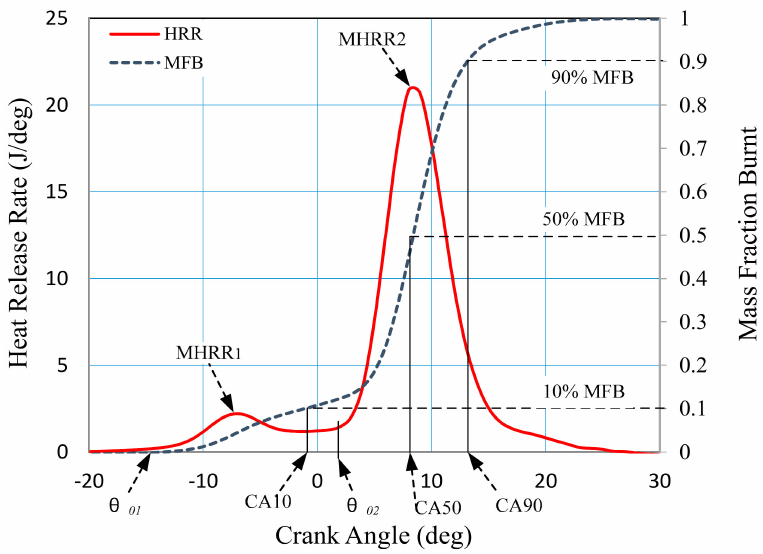
Figure 7. Combustion parameters on HRR and MFB curves.